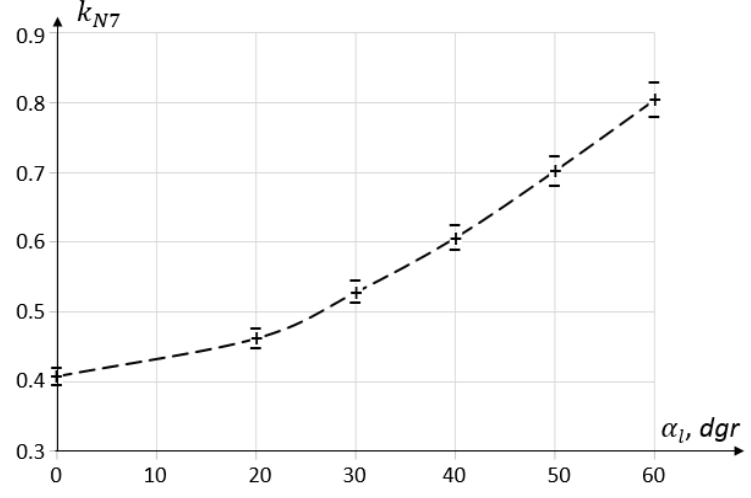
Figure 18. Influence of the angle of inclination α l on the power consumption factor k N 7 (experimental data).